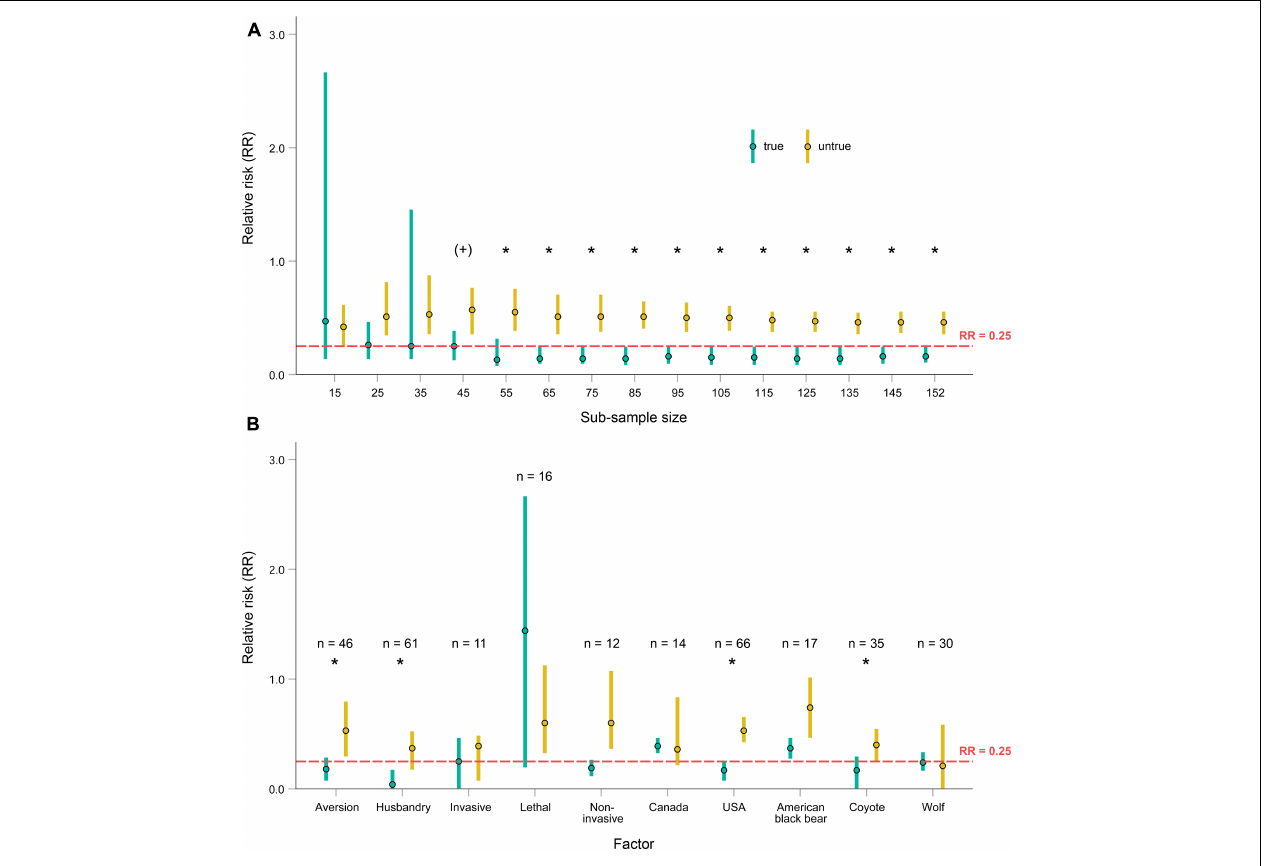
FIGURE 1 | The medians and 95% confidence intervals of the cases of true and untrue effectiveness in relation to the threshold of the relative risk (RR) = 0.25 across random sub-samples (A) and intervention categories, countries and predator species with sample size larger than n = 10 (B) . The asterisks show the statistical significance of the difference between the cases of true and untrue effectiveness ( p < 0.05) and the sign (+) indicates its marginal significance (Mann–Whitney U = 124.5, p = 0.059). Sample sizes are shown above the graphs.